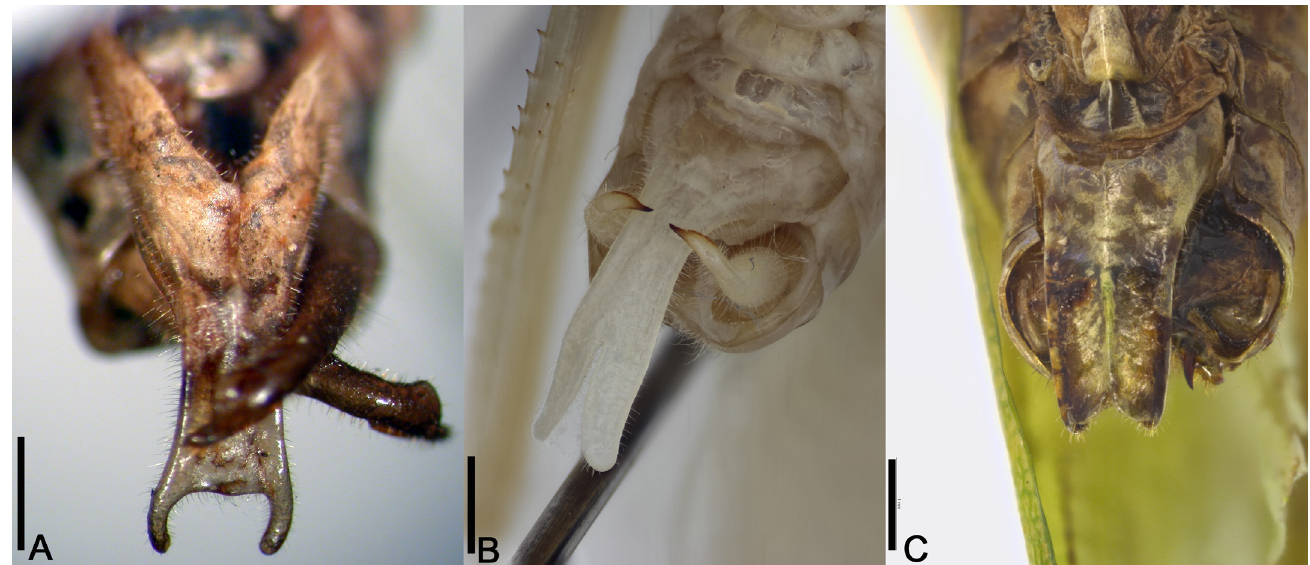
Fig. 3. Subgenital plates of male Lunidia species. A. L. viridis ; B. L. acuticercata ; C. L. bicercata sp. n. Scale bars: 1 mm.